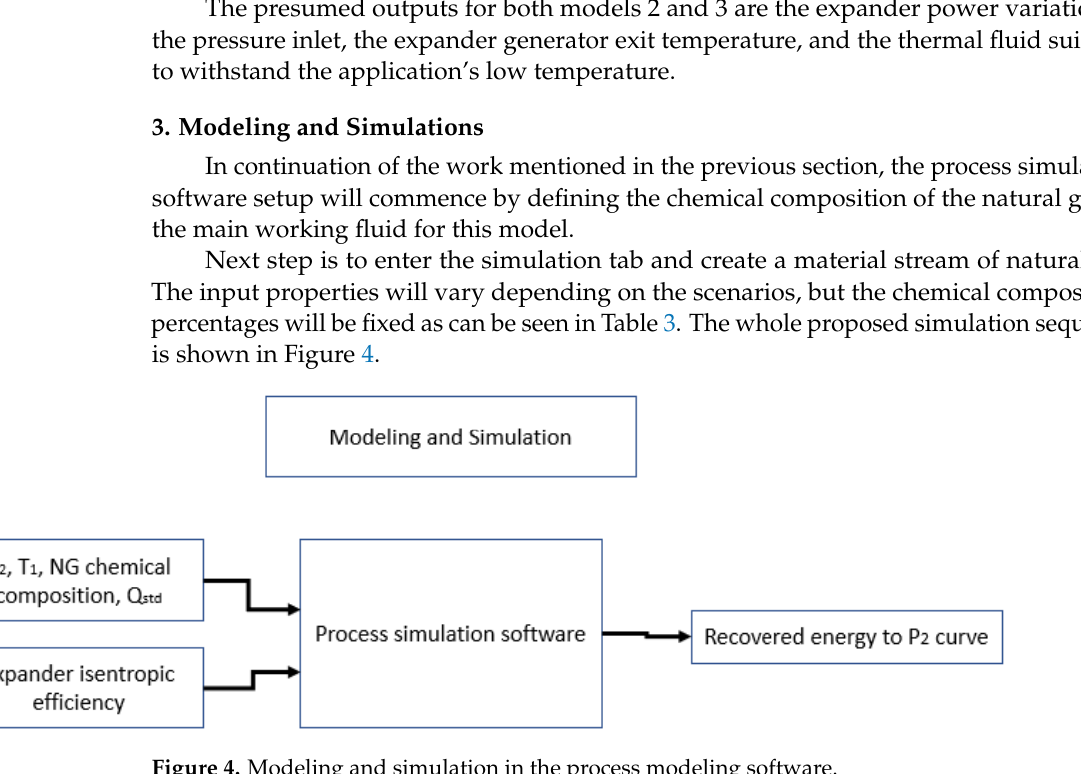
Figure 4. Modeling and simulation in the process modeling software.